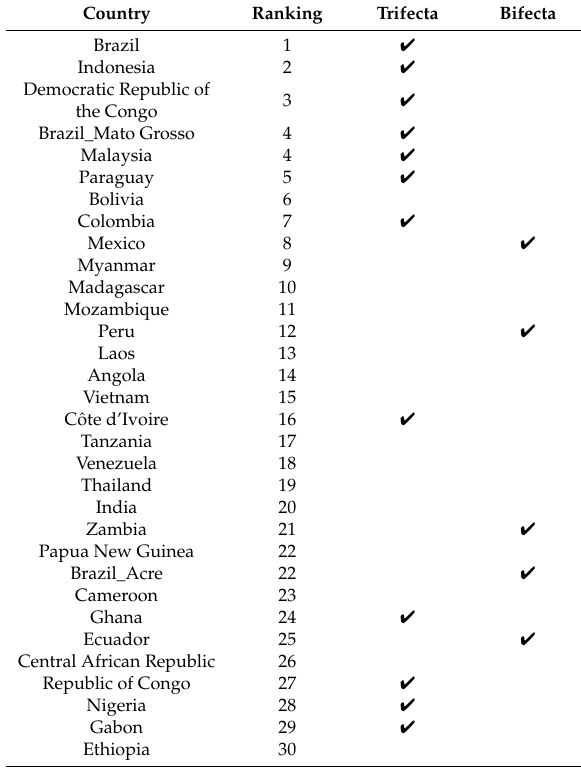
Table A1. Top 30 countries with the most tropical forest loss between 2001 and 2016. Country Ranking